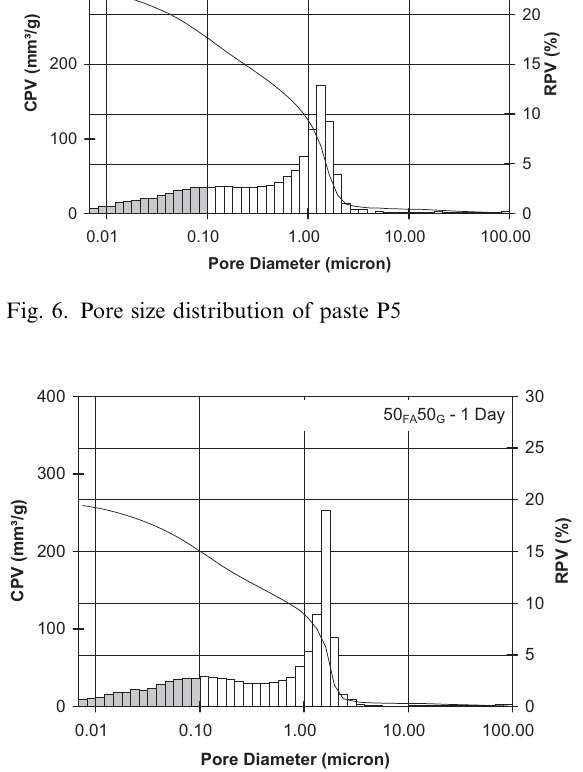
Fig. 7. Pore size distribution of paste P6